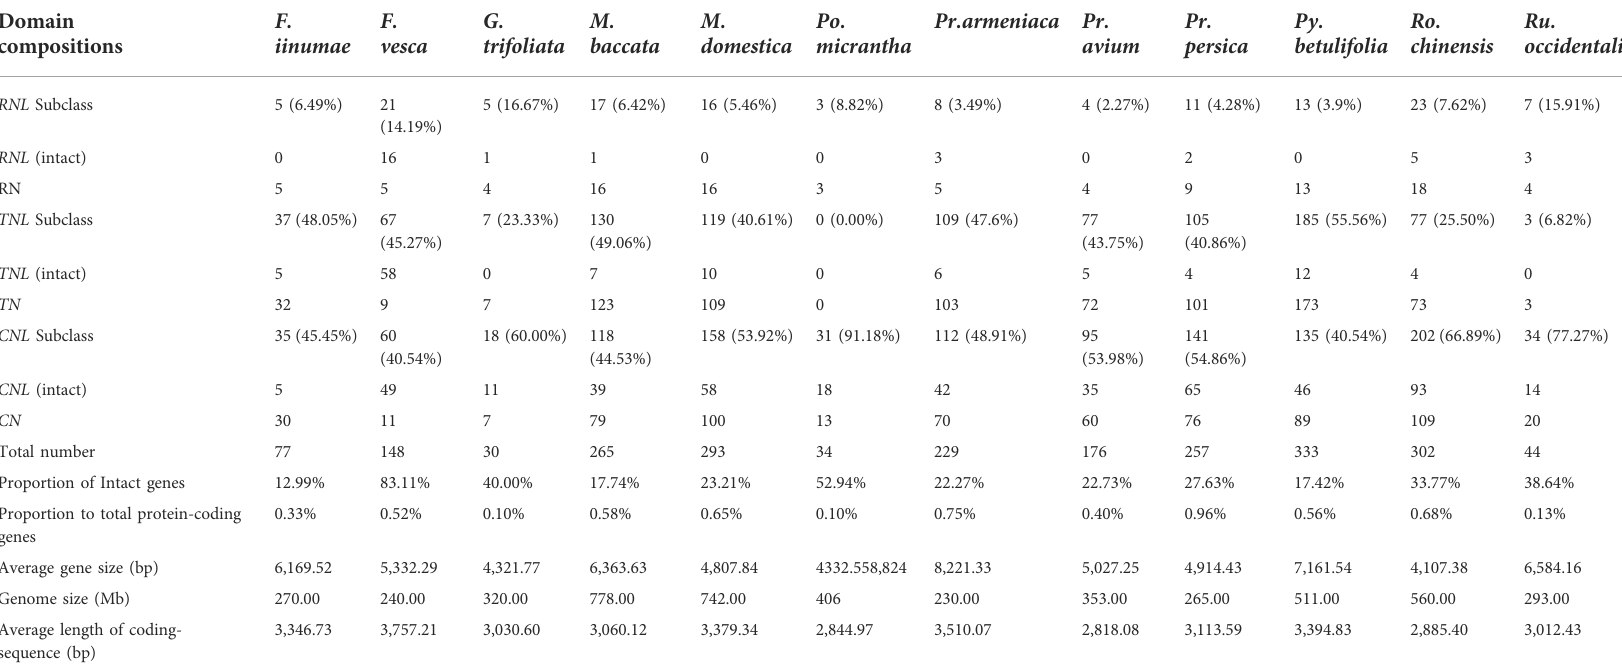
TABLE 1 The number of NBS-LRR genes identi fi ed in 12 Rosaceae genomes. Domain compositions